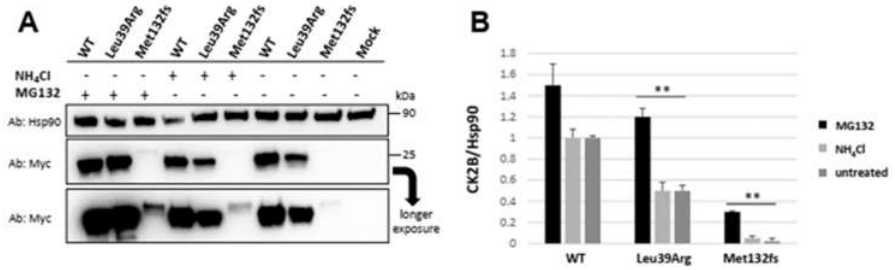
Figure 8. The mutant CK2beta(CK2B) protein amount is regulated by proteasome-mediated degra- dation. ( A ) HEK293 cells were either transfected with wild-type or mutant CSNK2B Myc-tagged constructs and then treated or not treated with MG132 or NH 4 Cl for 4 h. A representative Western blot shows that MG132 effectively blocks the proteolysis of mutant CK2beta proteins. ( B ) Histo- gram showing a significant increment in the expression of both mutant proteins upon MG132 treatment compared to untreated or treated with NH 4 Cl. ** p < 0.01 calculated by Student’s t-test (two-tailed, homoscedastic). The CK2beta protein level was normalized to Hsp90 expression used as a loading control.